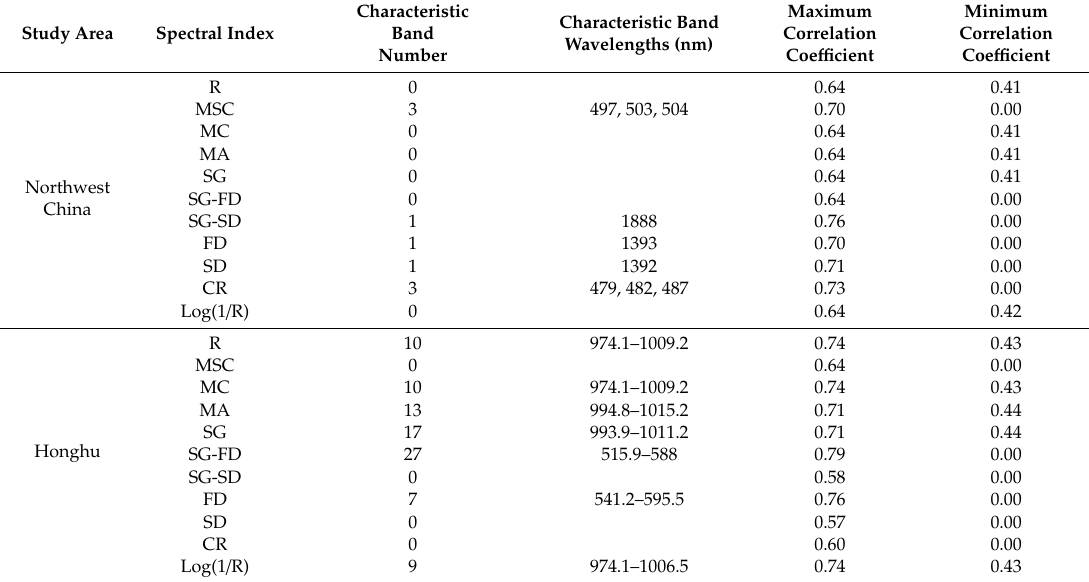
Table 2. The feature bands and the correlation coe ffi